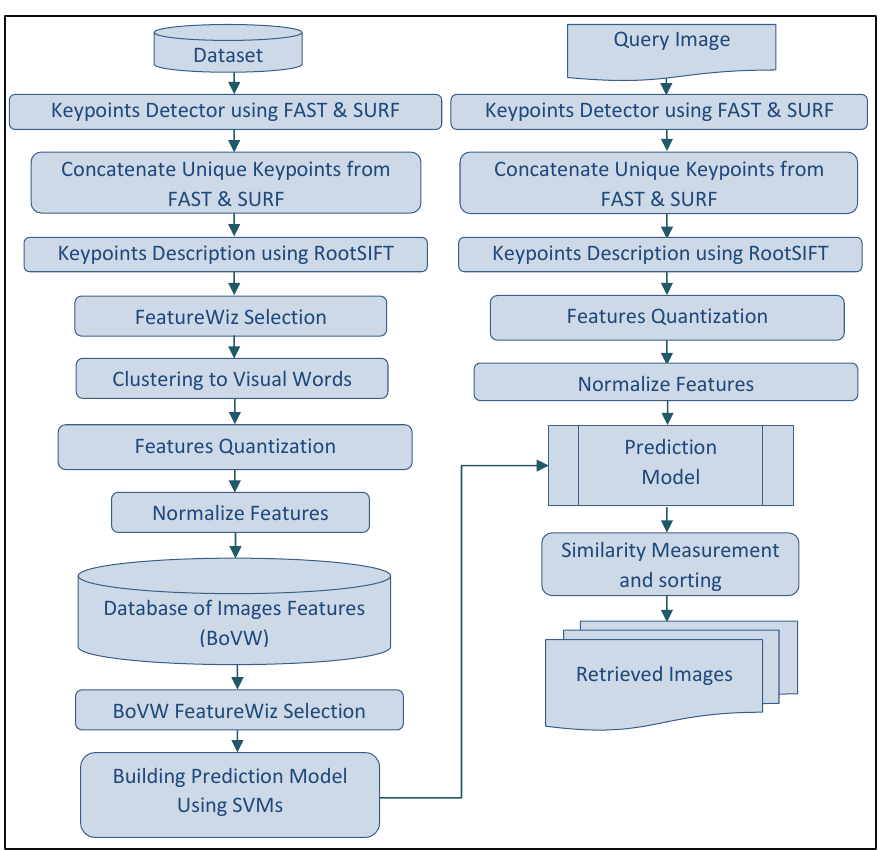
Figure 1. Flowchart of the proposed